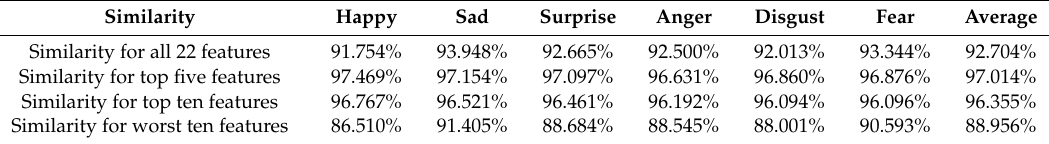
Table 12. The SS with respect to all expressions using all 22 features, top five, top ten, worst ten.